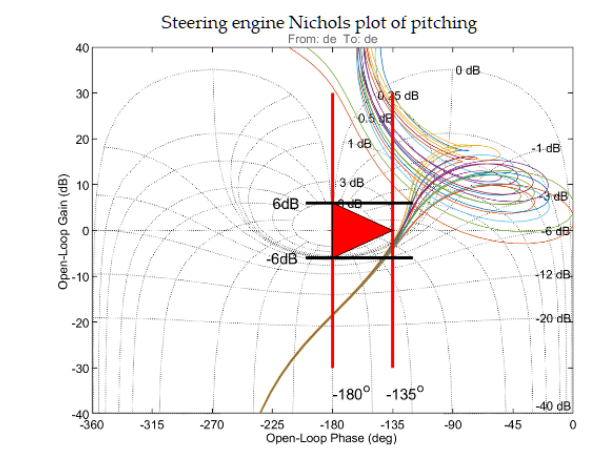
Figure 15. The Nichols diagram of pitch rate loop.